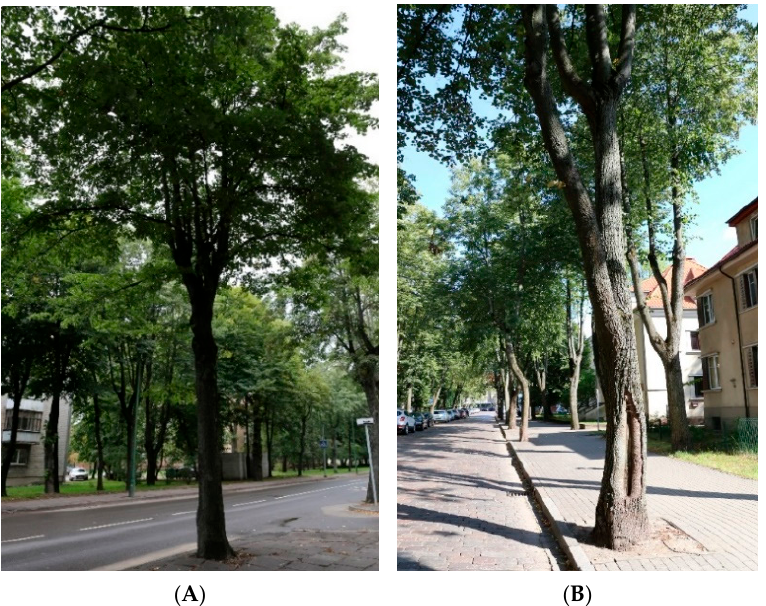
Figure 2. Examples of healthy and damaged trees in city streets. ( A ) Healthy tree, Sportininku Street. ( B ) Damaged tree, Neries Street. (Photos: Aist ė Povilaitien ė ).